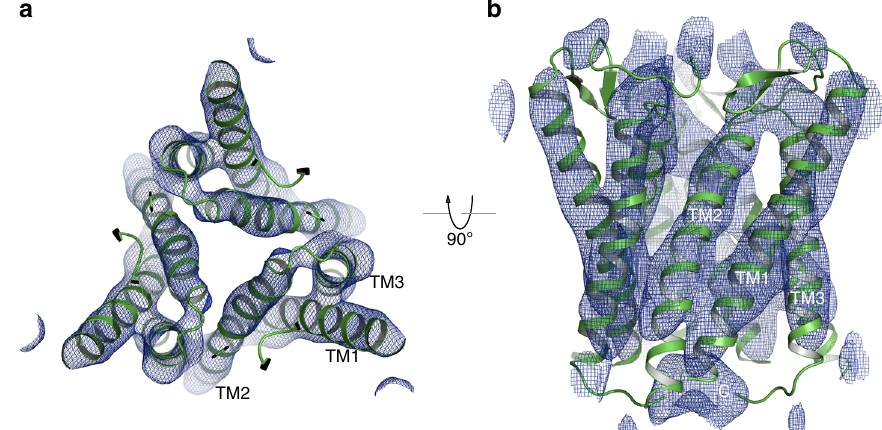
Fig. 2 Comparison of X-ray structure of sCtr1 cryst with EM reconstruction of hCtr1. a The sCtr1 cryst trimer structure (in green) is fi tted into the electron crystallographic reconstruction of hCtr1 at ~7 Å resolution (EMD-1593), shown as blue mesh. b Orthogonal view as in ( a )